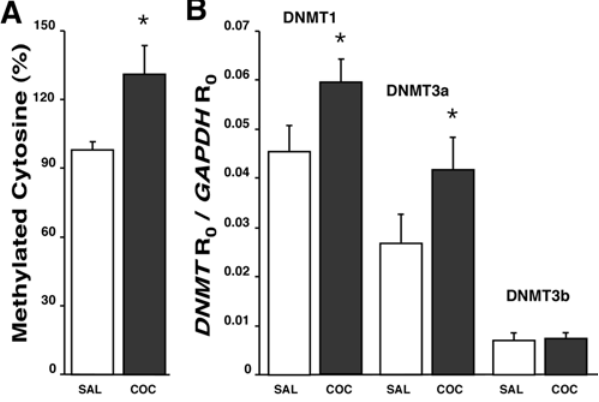
Figure 7. Effects of maternal cocaine exposure on global DNA methylation and DNMT gene expression in 30-day-old pups. (a) Relative levels of global DNA methylation in hippocampal pyramidal tissues of P30 pups. Each bar represents the mean 6 SEM (n=10). *p , 0.05 compared to saline-control group. (b) Expression levels of DNA methyltransferases relative to GAPDH as internal standard. *p , 0.05 compared to the respective saline-control group. doi:10.1371/journal.pone.0001919.g007 PLoS ONE |